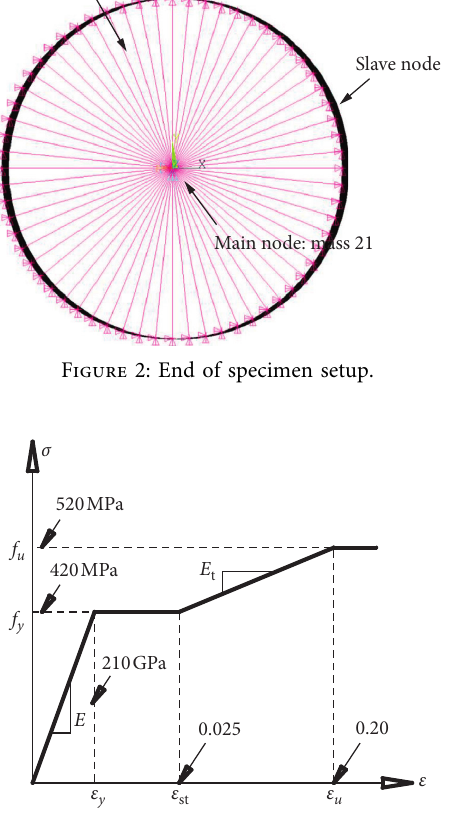
Figure 3: Stress-strain relationship of steel for FEA models. Table 2: Effect of section thickness on buckling